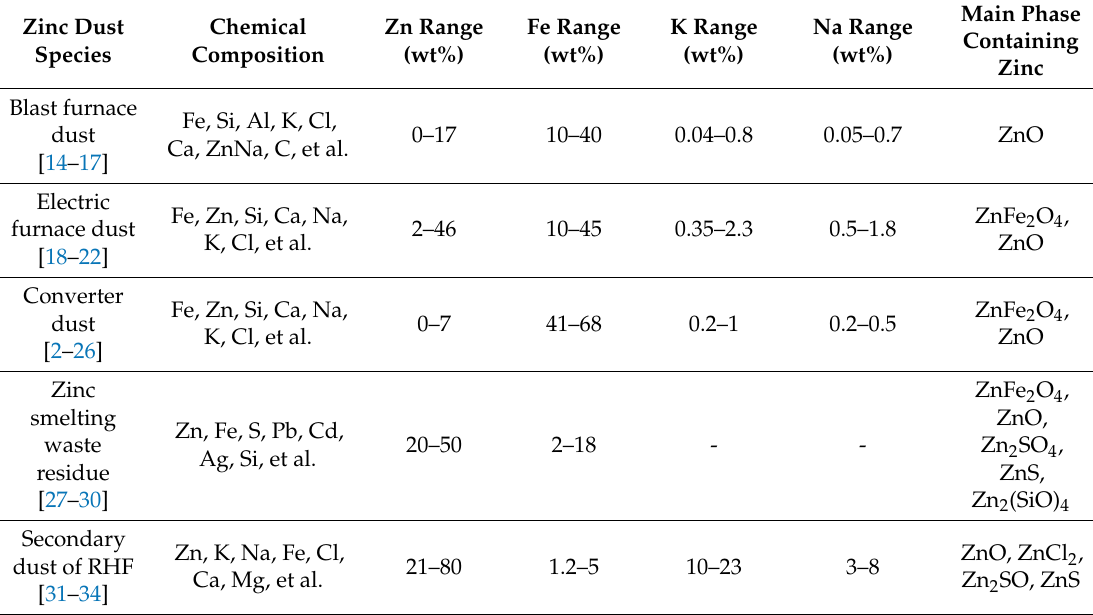
Table 1. Main chemical composition characteristics of zinc-containing dust in steel